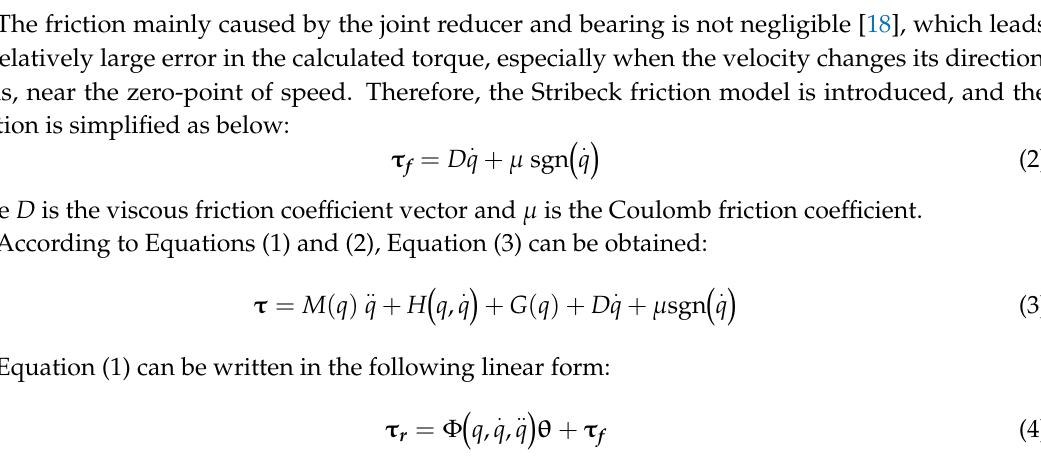
Figure 2. D-H structure of the collaborative robot.